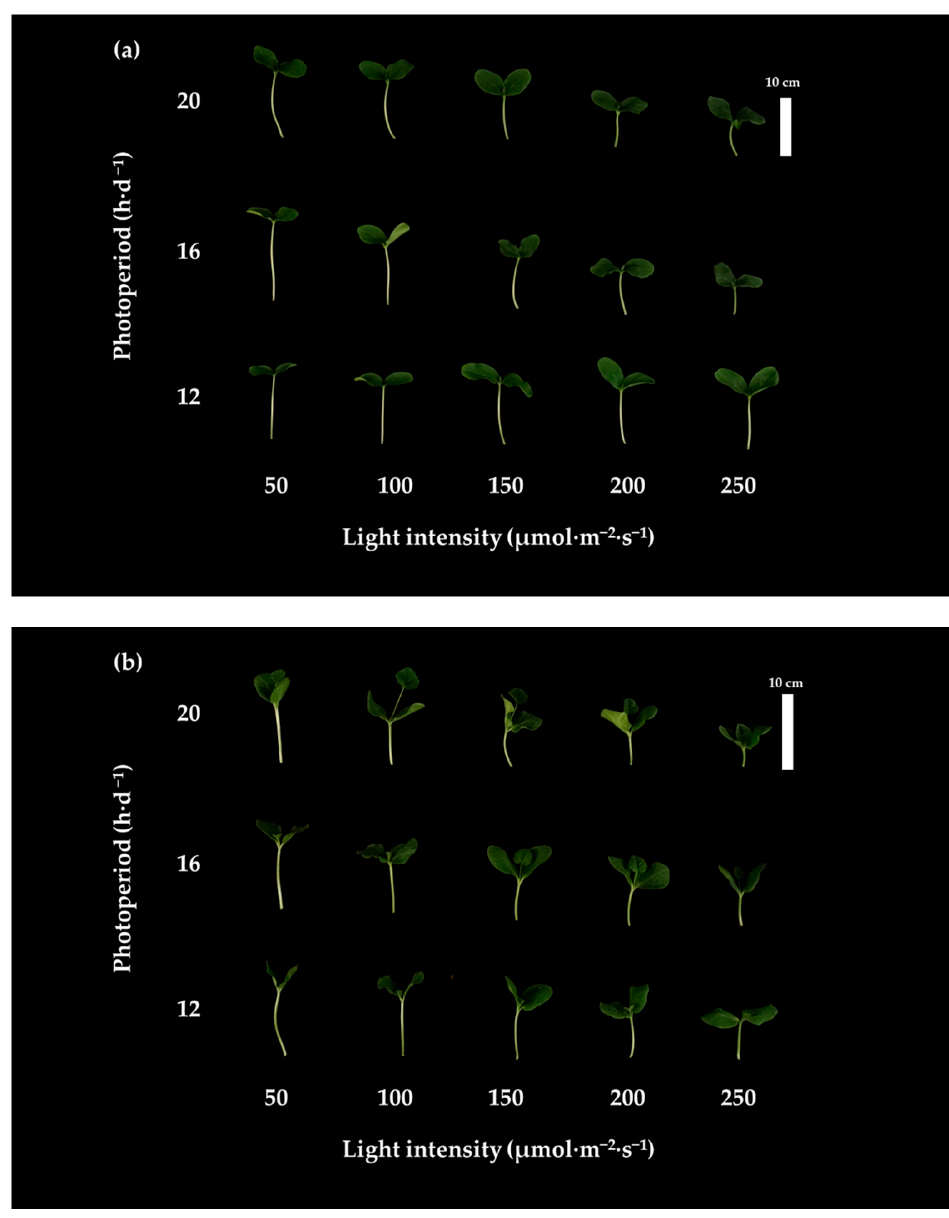
Figure 8. Cucumber scions ( a ) and rootstocks ( b ) cultivated under different photoperiod and light intensity conditions in a PFAL. Table 3. Growth of cucumber scions as affected by the different photoperiod and light intensity at 6 days after cultivation in a PFAL.